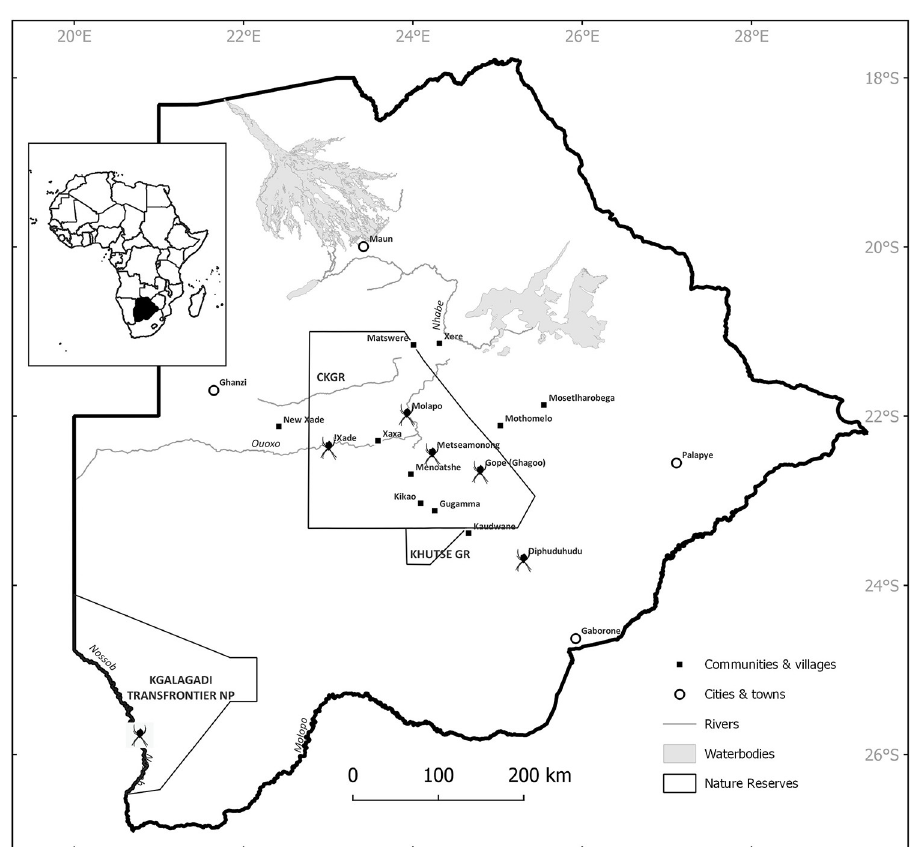
Fig 1. Map of Botswana. Places visited and indicated in text. Spider symbols indicate communities where the garden orb-web spider, Argiope australis (Walckenaer 1805) (Araneidae), is thought to be used as arrow poison. Map generated in QGIS 3.24.1 by T.L. Bird using personal datasets and open source shapefiles.